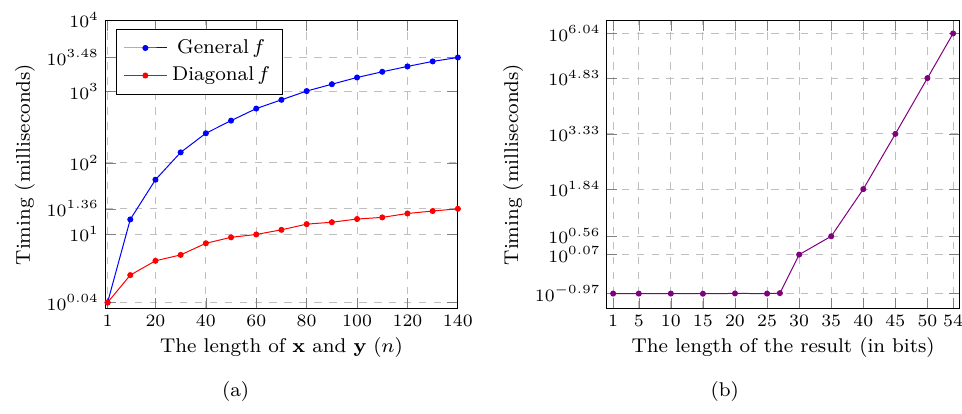
arithmetic p 12